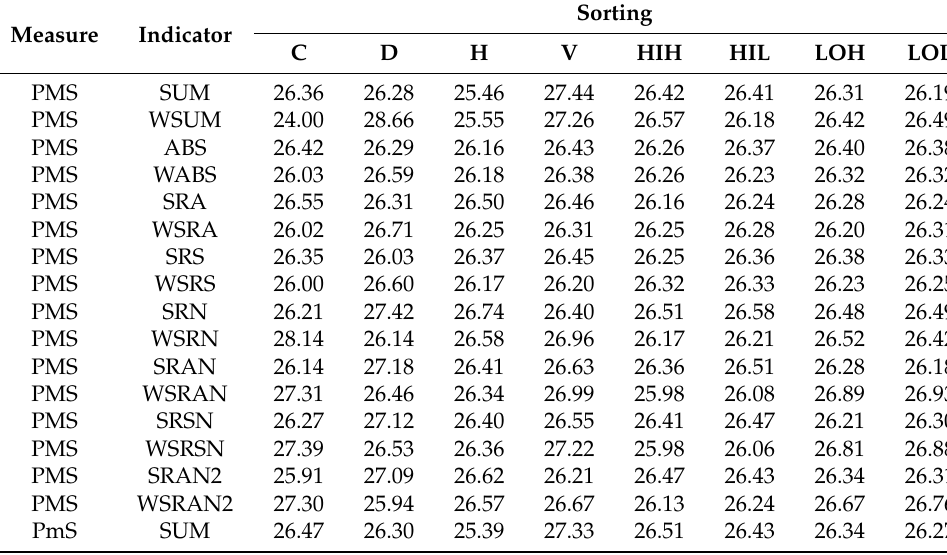
Table 7. Computational results for the dispatching rules: ARPD values